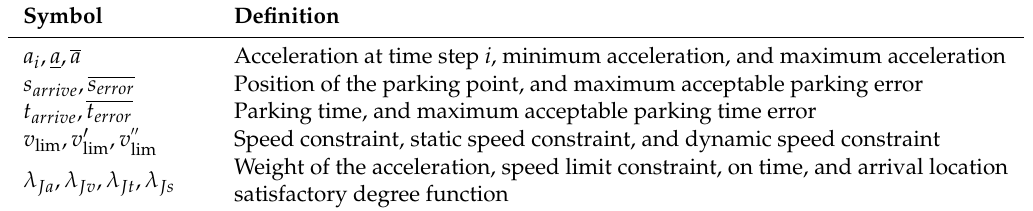
Table B1. Subscripts, parameters, and variables used in the mathematical